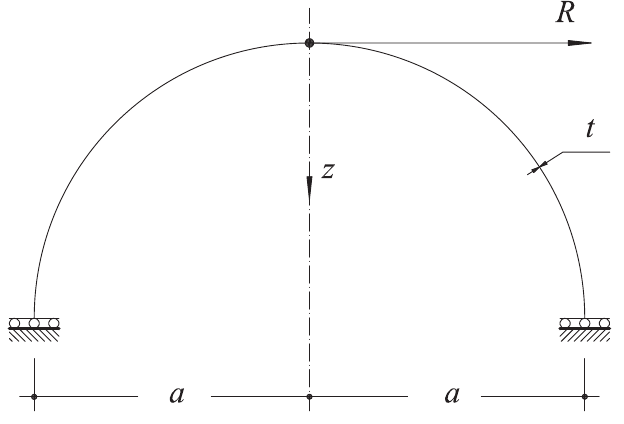
Figure 9. Hemispherical shell under uniform pressure. Cross